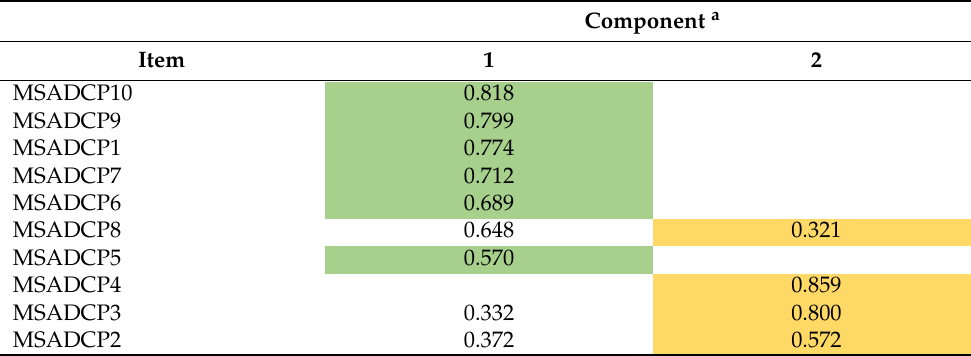
Table 10. Satisfaction Scale rotated component matrix.